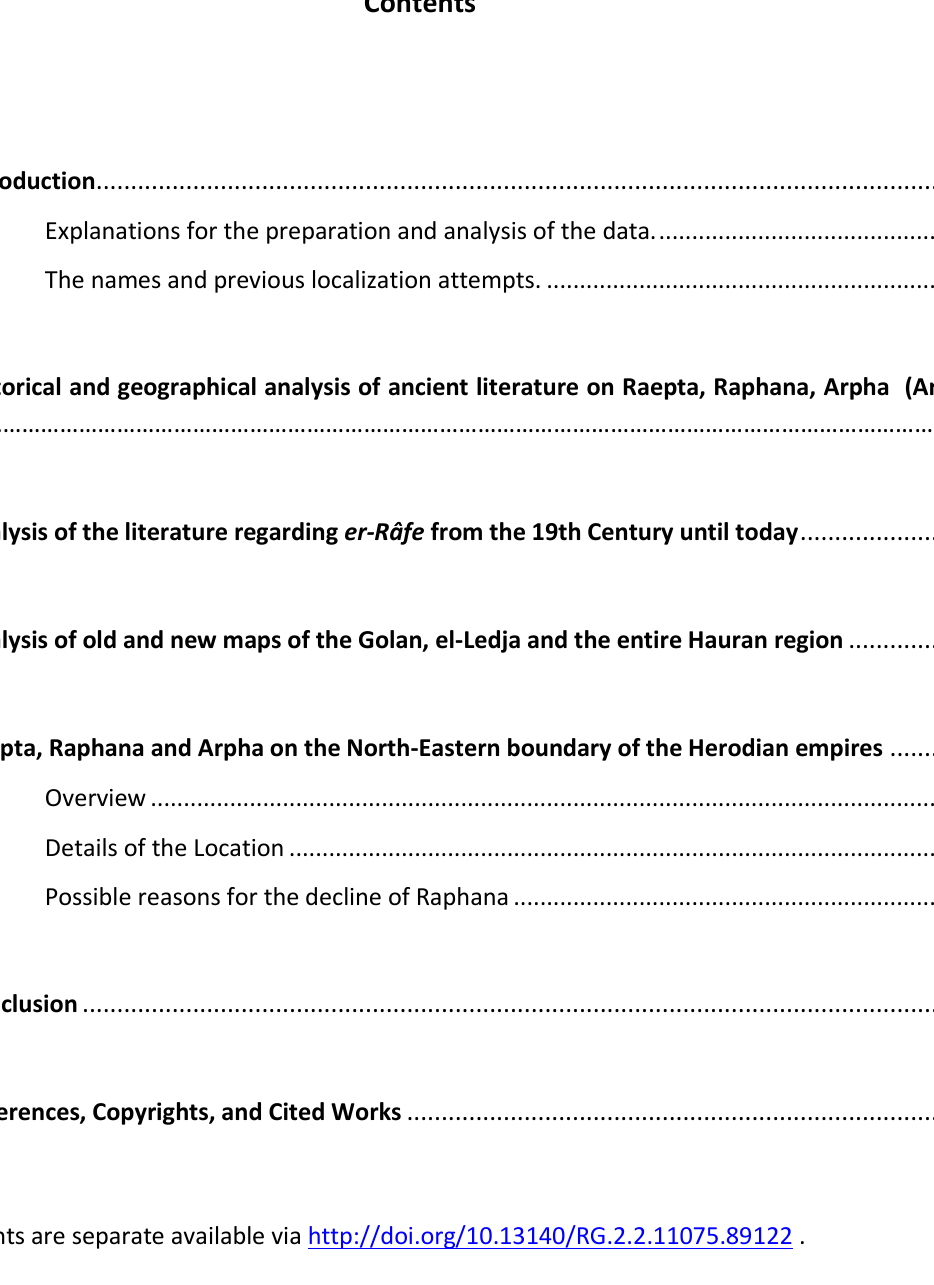
Supplement A: Position table of all mentioned Locations in Palestine Grid and Longitude/Latitude Page I-III Supplement B: Map of southern Syria and northern Jordan, with the mentioned locations of this